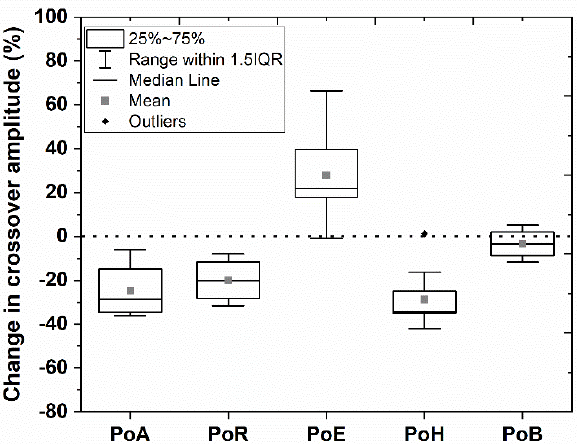
(cid:17) × 100 × 100(cid:4673) of mud samples from of mud samples from differ- (cid:3033)(cid:3045)(cid:3032)(cid:3046)(cid:3035)